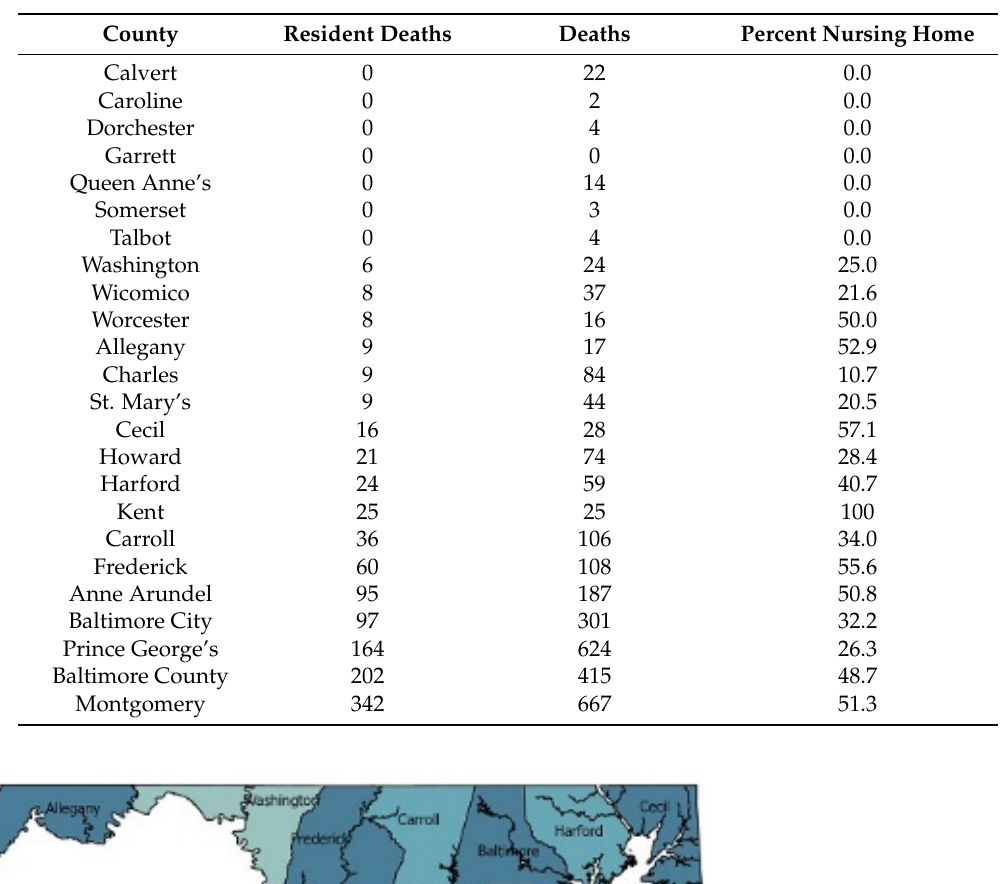
Table 1. COVID-19 deaths in Maryland by county.